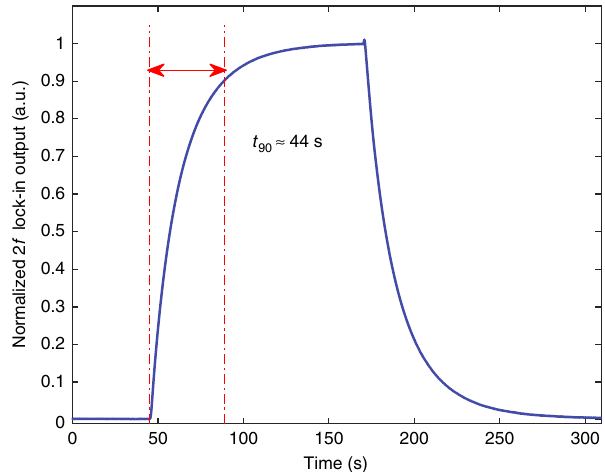
Fig. 7 Results of response time test. Normalized 2 f signal recorded during gas loading. The nominal laser wavelength is tuned to the center of the P (13) line and at the same time modulated sinusoidally at 9.5 kHz. At ~45 s, 1000 ppm acetylene gas was loaded into the gas chamber with the differential pressure of ~1 bar. At ~170 s, nitrogen was loaded into the gas